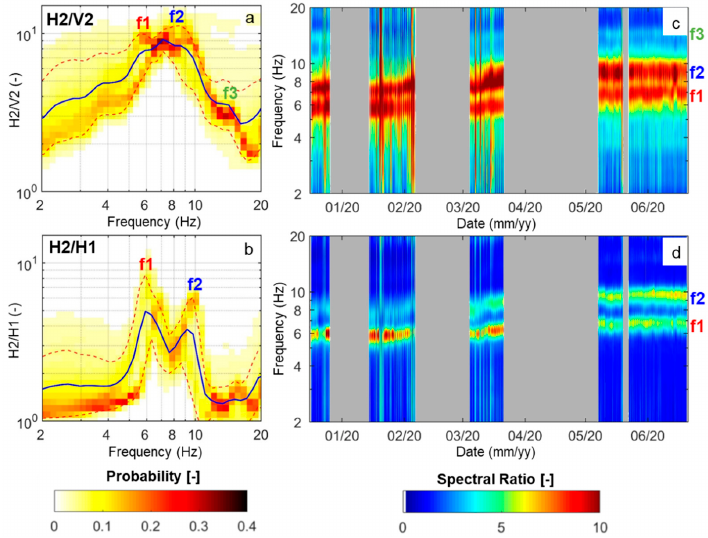
Figure 5. Ambient seismic noise spectral ratios. PDFs of the hourly computed ( a ) H2/V2 and ( b ) H2/H1 spectral ratios, with average (blue line) and 10th–90th percentiles (dashed red lines). Temporal evolution of ( c ) H2/V2 and ( d ) H2/H1 in the monitored period. The main spectral peaks are highlighted with f1 to f3 (on the right). No data periods are shaded in gray.